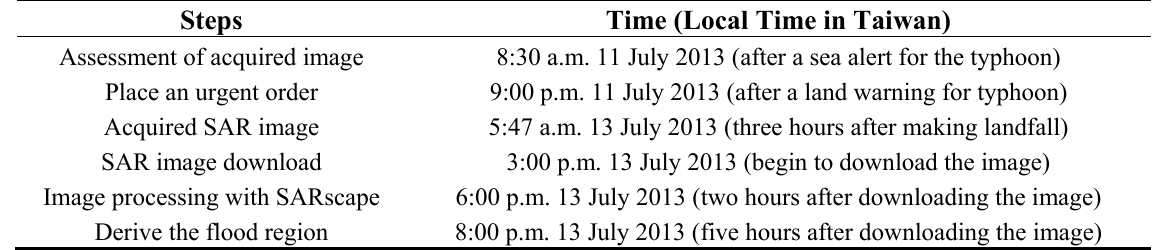
Figure 2. ( a ) Formosat-2 true color satellite image of I-Lan County, which is located in the northwestern part of Taiwan. The region in the green triangle is Lanyang Plain. ( b ) The region denoted as the purple square is covered by the SAR image. The region denoted as the yellow square is the same geographic position as the areas shown in Figure 3. Table 1. The timetable of SAR image requesting, downloading and